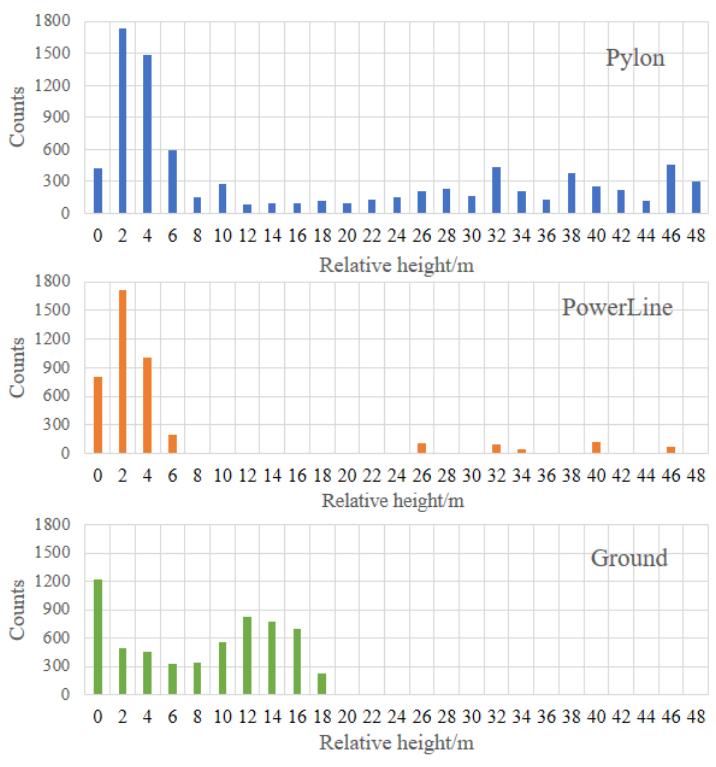
Figure 3. The vertical distribution of a pylon, power line and ground cell respectively. Figure 4 shows the preliminary result of the candidate points of pylon, power line and ground objects. They are colored in blue, orange and green, respectively. It can be seen that most of the points were effectively extracted. However, there were still a few mis-extracted points because an object might have been divided into two cells by gridding. The red circle A in Figure 4 shows the missing power line points because the power lines were too close to the nearby trees. Because of the false empty layer, the scattered orange points in red circle B were extracted as power line points mistakenly. The blue rectangular C shows the pylons, where some power line points were extracted as pylons mistakenly. The blue rectangular box D shows a wrongly extracted pylon because it was similar to the height of the pylon.